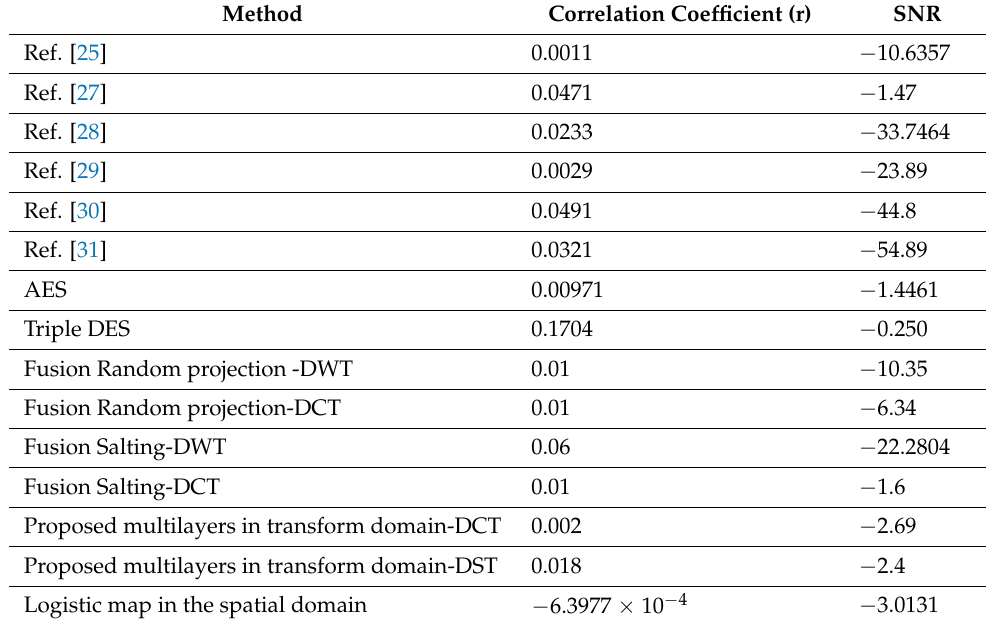
Table 6. Comparison based on statistical